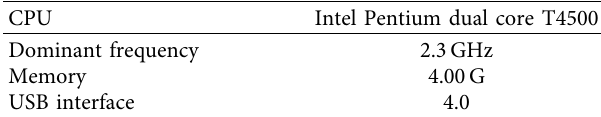
Table 2: PC related